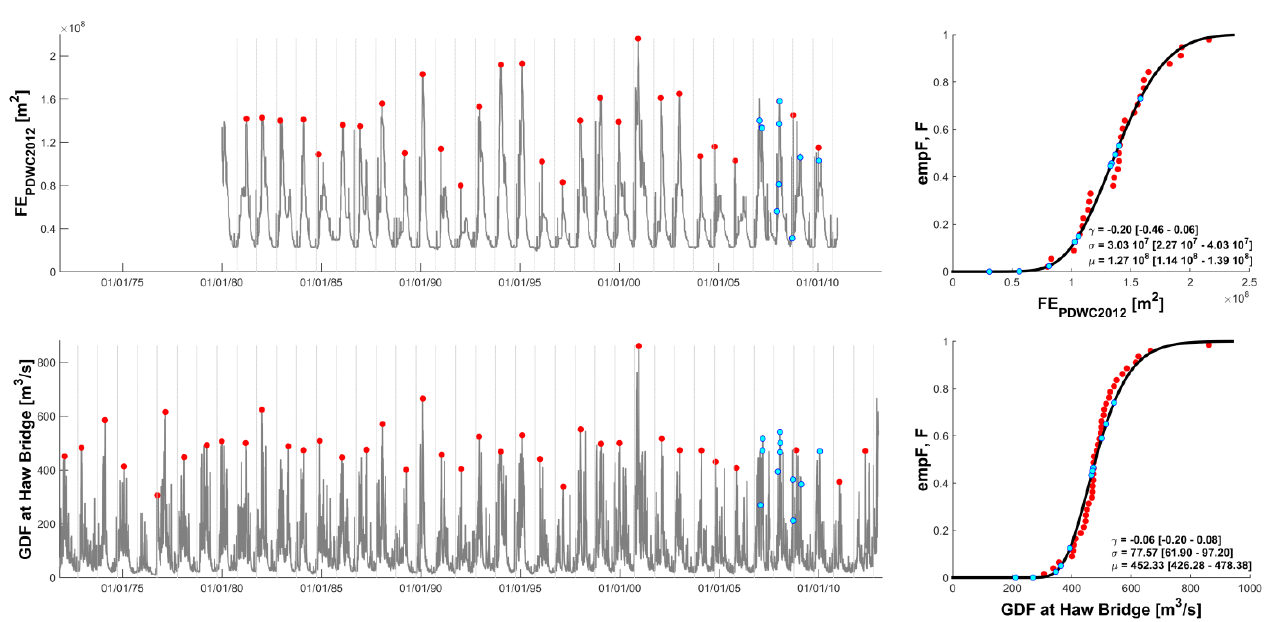
Figure 6. Yearly maxima (red dots) and CDF fit; the values of the continuous series at the times of satellite overpasses are also shown (blue